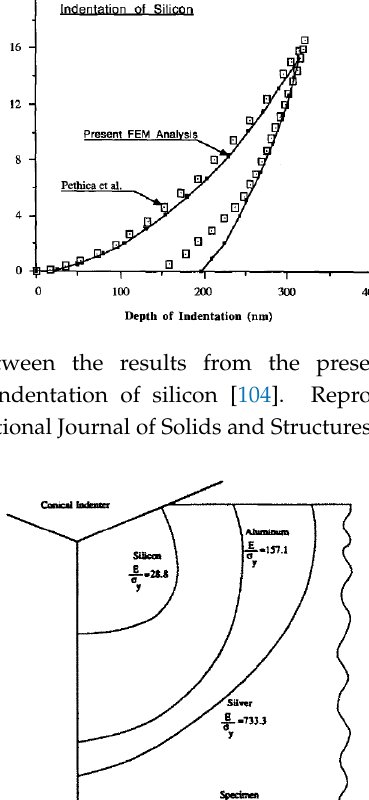
Figure 31. Comparison of the yield zones at a particular indenter angle of 136° for various E/ σ (cid:2935) , ratios for a depth of indentation of 203 nm [105].